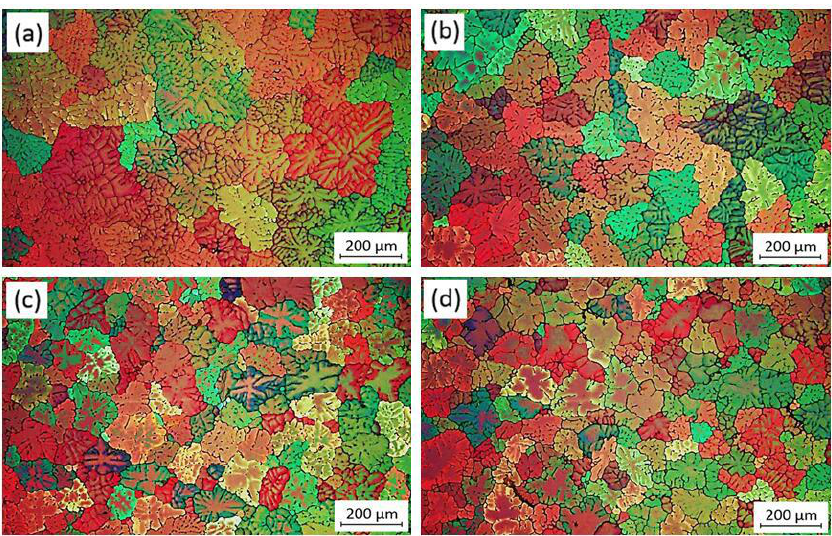
Figure 2. Micro-structure of one-half radius region of cross section of ingots prepared in different electromagnetic conditions ( a ) Conventional DC casting; ( b ) 10 Hz / 50 A; ( c ) 10 Hz / 100 A; ( d ) 0 Hz / 150 A.